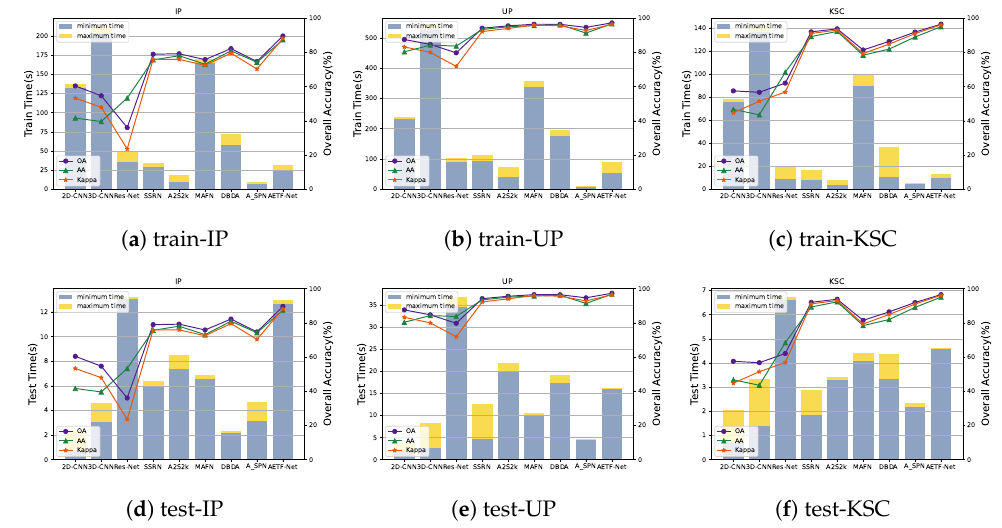
Figure 11. Comparison of computation time and overall accuracy of different